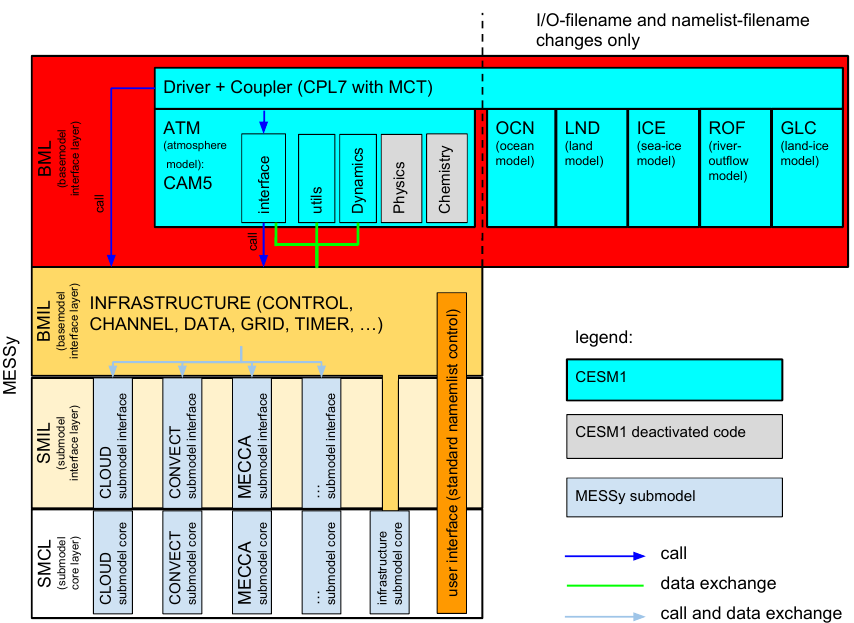
Figure 1. Diagram of CESM1 integration into MESSy. See also http://www.messy-interface.org/current/messy_interface.html for the generic MESSy interface